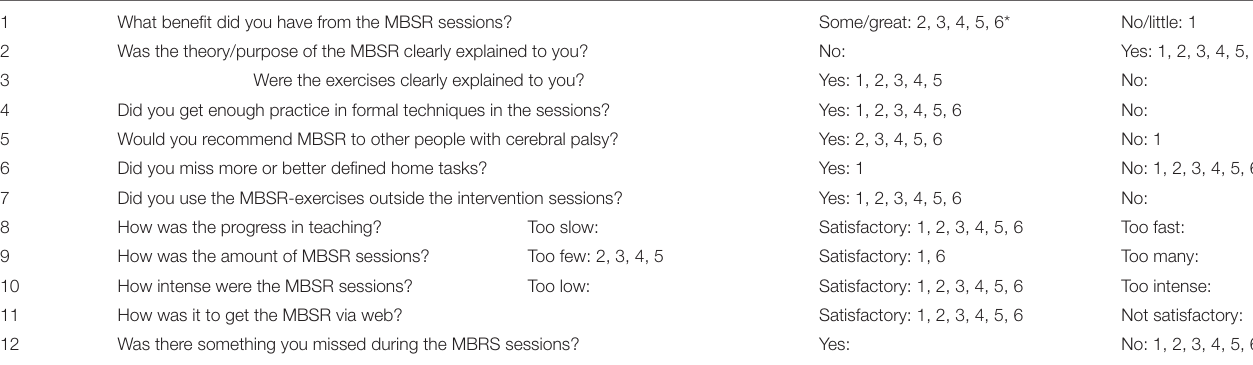
TABLE 4 | Custom-made evaluation